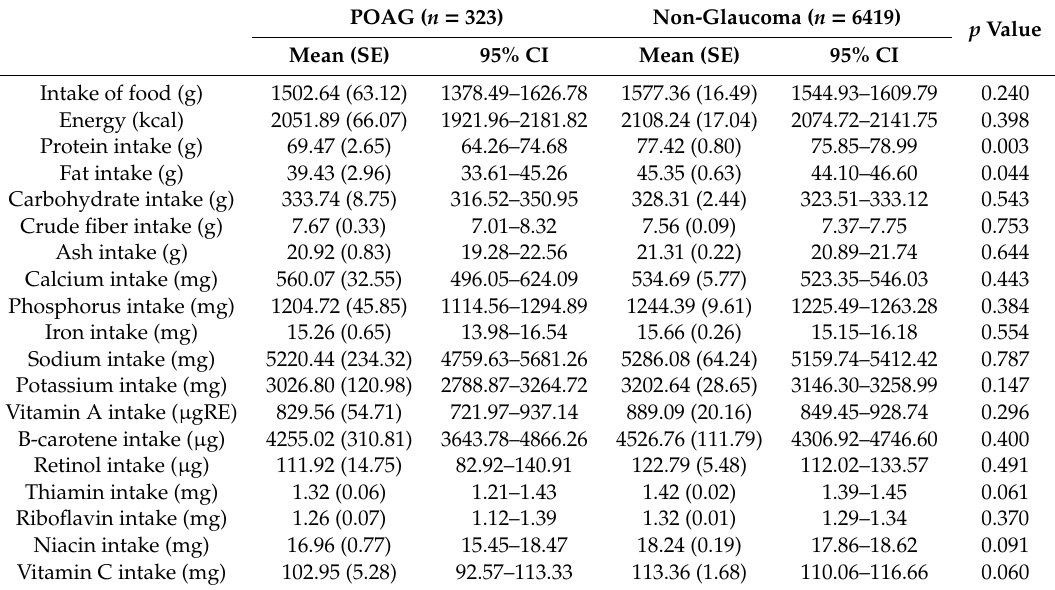
Table 2. Dietary intake between primary open angle glaucoma (POAG) and non-glaucoma